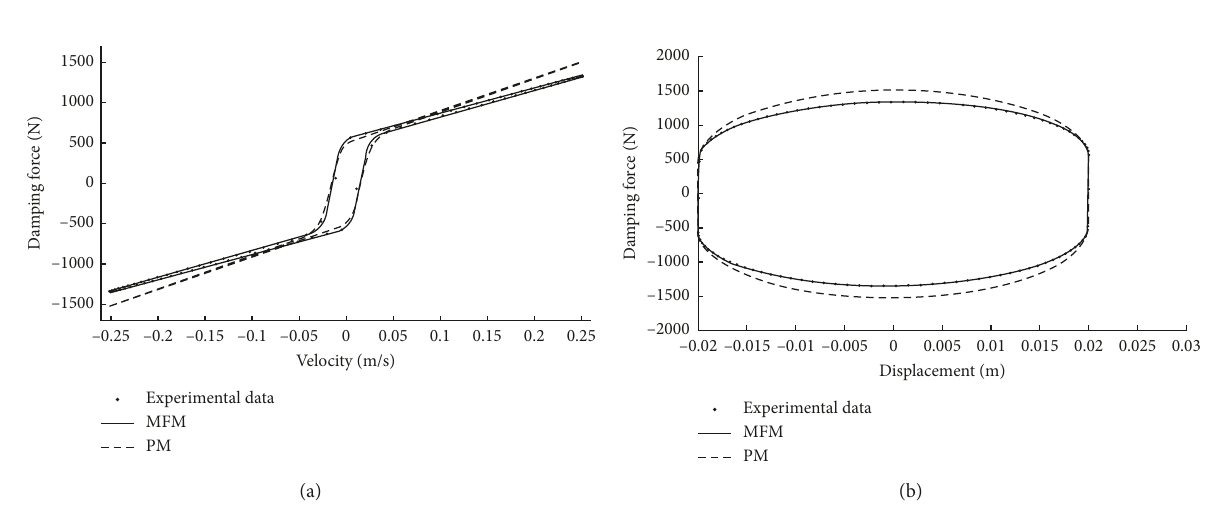
Figure 13: The comparison between MFM, PM, and experimental data when Amp force curve. (b) Piston displacement-damping force